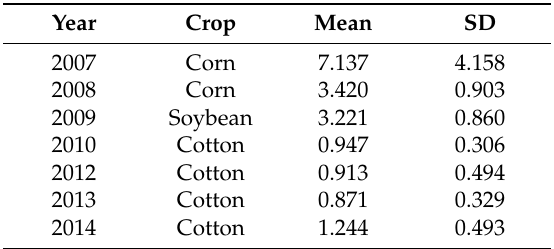
Table 3. Descriptive statistics on yield data (Mg ha − 1 ) at the field of study located in southwestern Dyer County in west Tennessee. Year Crop Mean SD 2007 Corn